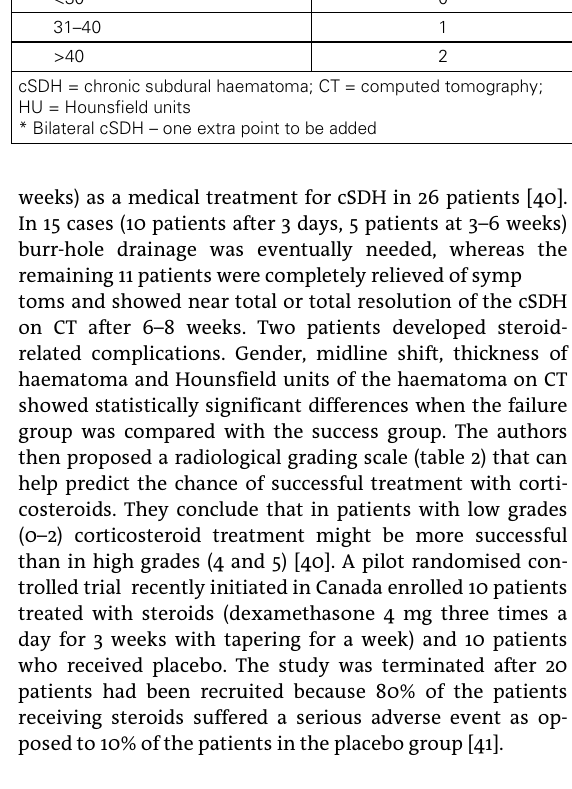
Table 3: Studies evaluating the treatment of cSDH with corticosteroids: results and recommendations. Study